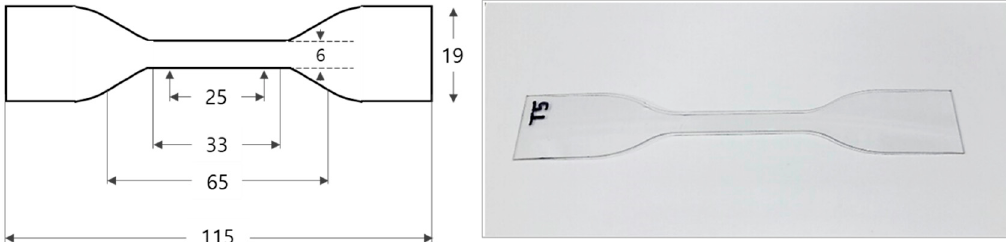
Figure 2. Dimensions and actual appearance of impact-strength specimen.